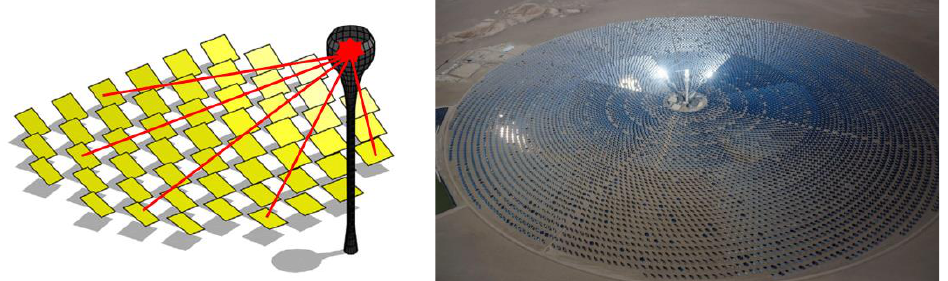
Figure 12. Schemes of the solar towers [110,111].